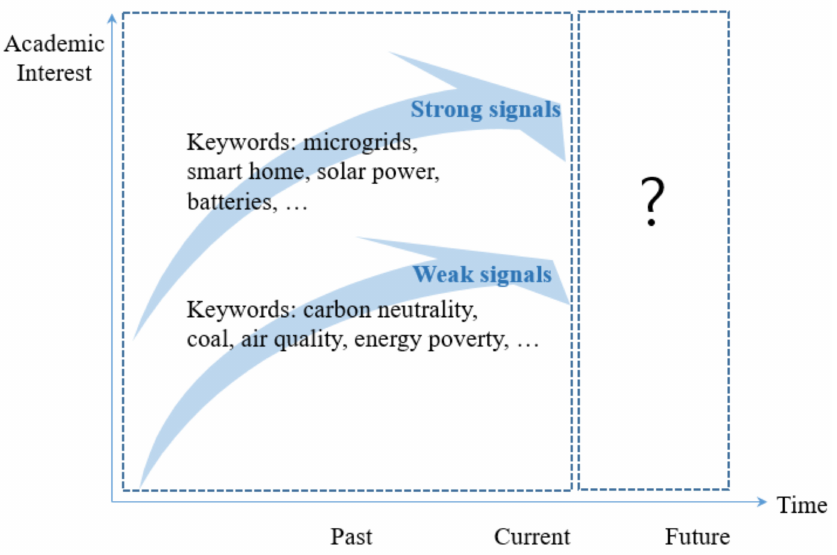
Figure 4. Keywords and flow of Strong signals and Weak